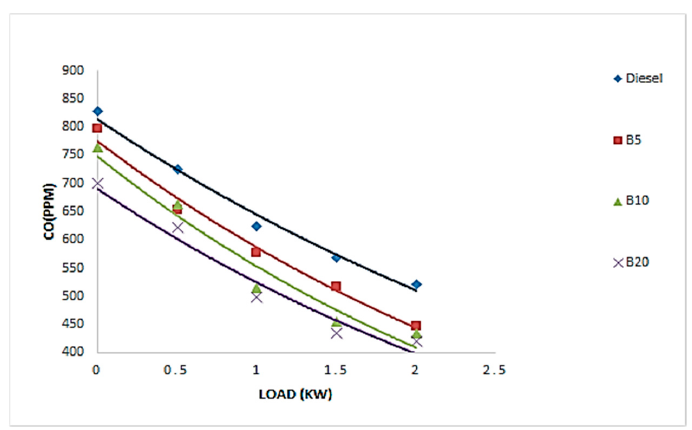
Figure 12. Variation in CO with respect to load.